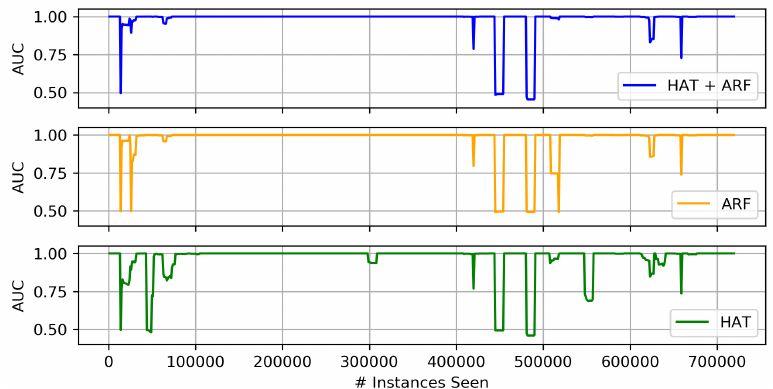
Figure 7. Comparison of HAT + ARF ensemble and their individual component performances on combined data.